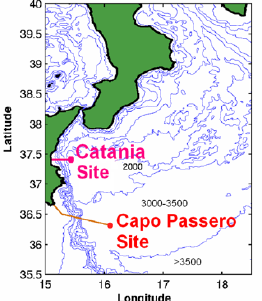
Figure 1. The Abyssal infrastructures realised by INFN offshore Sicily: Capo Passero (3500 m depth) will host KM3NeT/ARCA. The Catania infrastructure is entirely dedicated to multidisciplinary